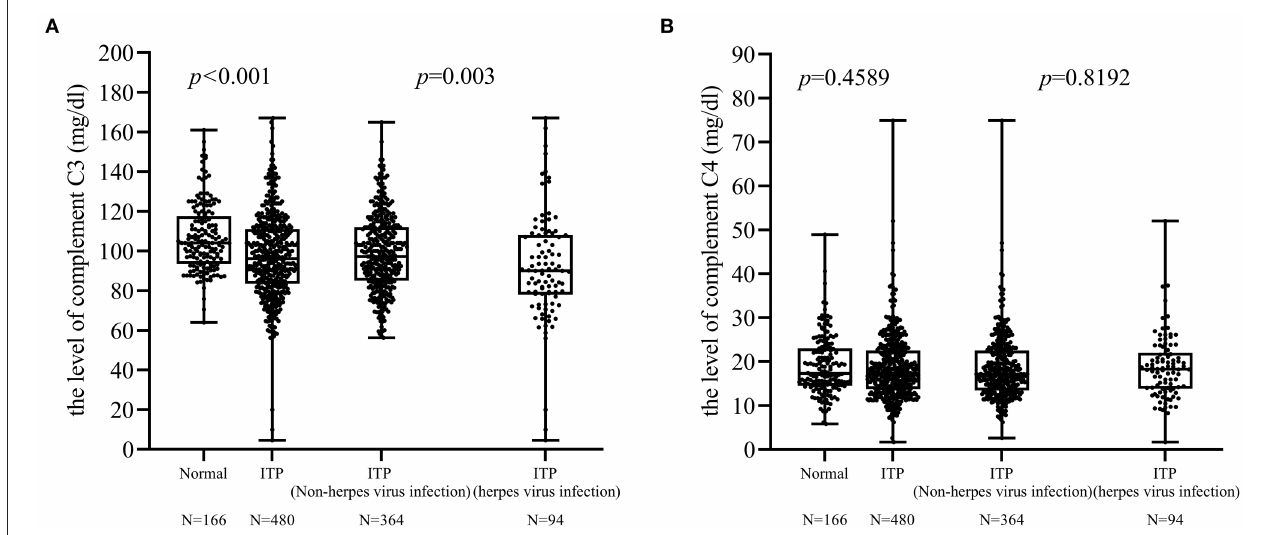
FIGURE 2 | Differences in complement C3 and C4. (A) There was a difference in the complement C3 levels between ITP patients with and without herpes virus infection ( p = 0.003). (B) No difference was found between these two groups in complement C4 levels.